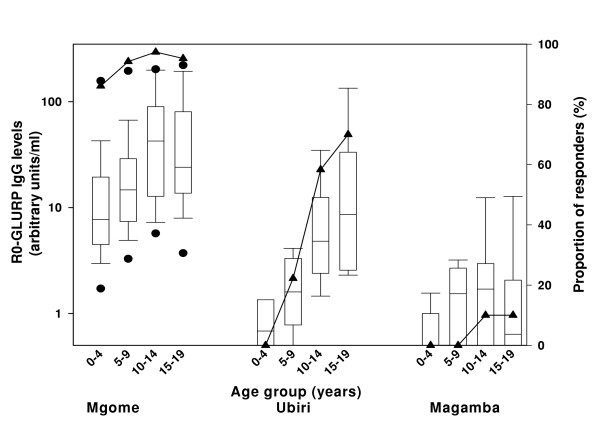
Age-specific IgG responses to recombinant R0-GLURP in three villages: Mgome (high malaria transmission), Ubiri (moderate malaria transmission) and Magamba (low malaria transmission). The levels are presented as arbitrary units on a logarithmic scale. Box plots illustrate medians with 25th, 75th and whiskers for 10th and 90th percentiles including outliers (5th/95th percentiles). Lines with filled triangles represent proportion of responders in percentages.